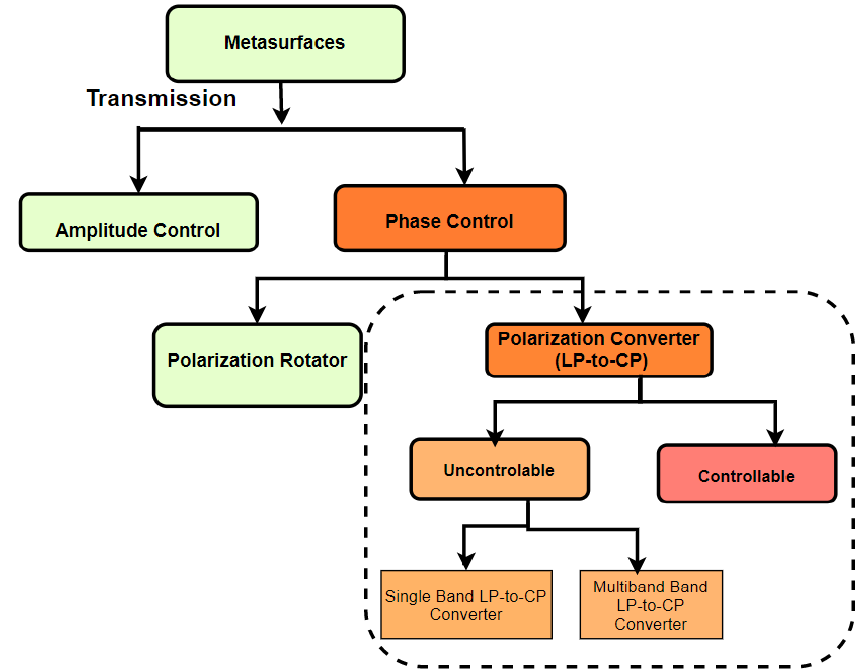
Figure 3. Scheme for the article.